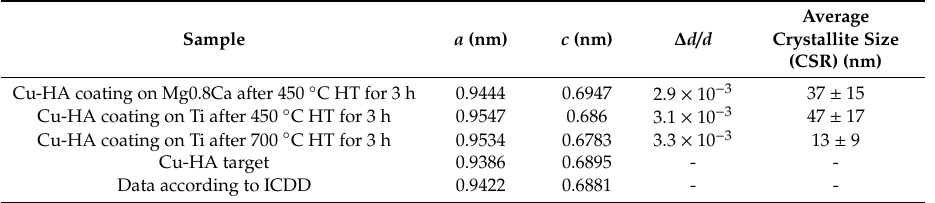
Table 1. Calculated values for hydroxyapatite structural parameters ( a and c —lattice parameters). Sample